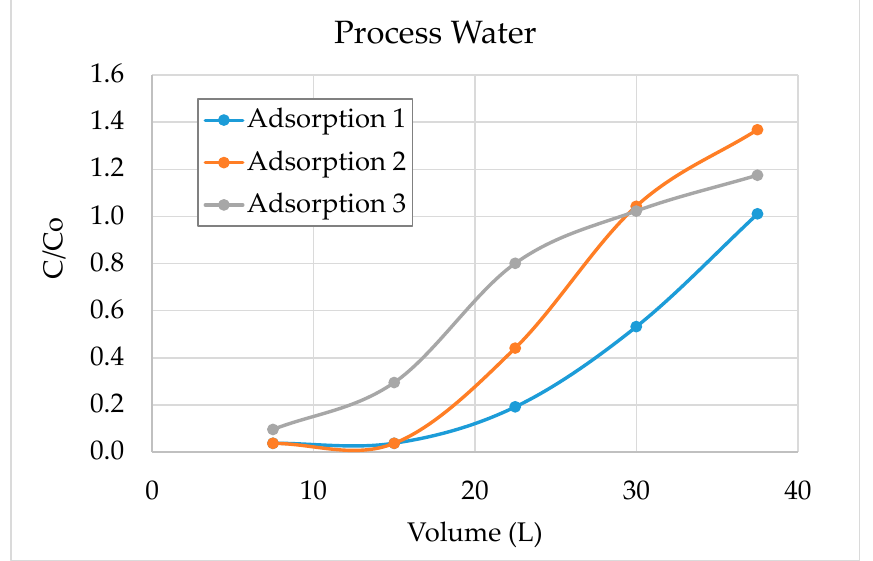
Figure 11. Breakthrough curves of the sulfate ion for the three adsorption experiments conducted on the Process Water.